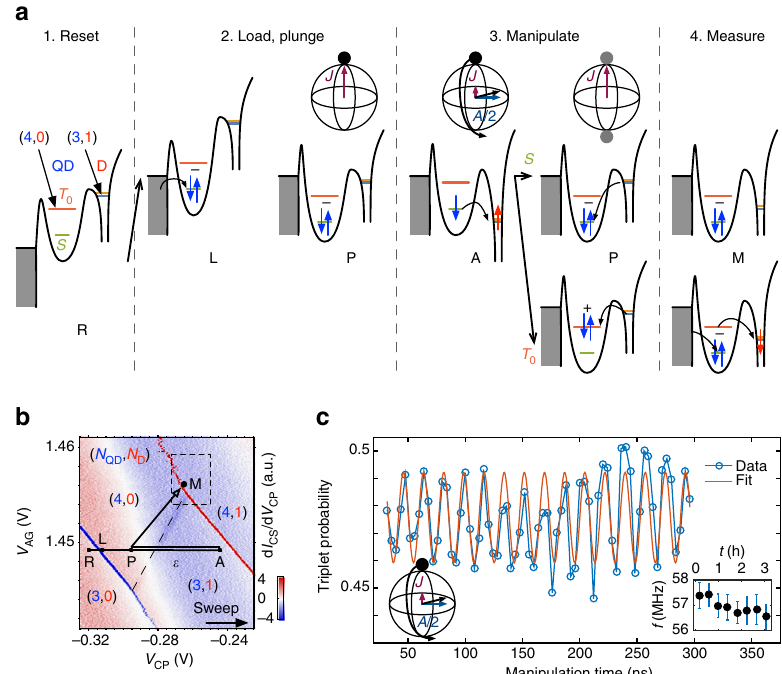
Fig. 2 Hyper fi ne ST rotations. a Pulse sequence for the spin manipulations with schematic conduction band diagrams through the reservoir, QD and donor. The system is initialized as (4, 0) S and plunged to point P. Then, the detuning is pulsed rapidly to point A, which yields a separated (3, 1) S . After a given manipulation time in (3, 1), which rotates the spin between S and T 0 , it is pulsed back to point P. The state is then either (4, 0) S or (4, 0) T 0 , and is measured by going to point M, where an enhancement in CS signal occurs (see Supplementary Note 4). b QD-D charge stability diagram. Overlaid are the different points of the experiment ’ s pulse sequence. The detuning ϵ is de fi ned along the black line with zero detuning at the center of the (4, 0) ↔ (3, 1) transition. c Triplet probability vs. manipulation time for ϵ = 950 μ eV. The oscillation frequency is f = 56.9 MHz. This is not the bare hyper fi ne frequency due to a residual exchange of J / h = 27 MHz, see Fig. 3c. Inset: Frequency of the oscillations for repeated measurements over 3 h. Each point represents data averaged over 22 min, and the error bar represents the 95% con fi dence